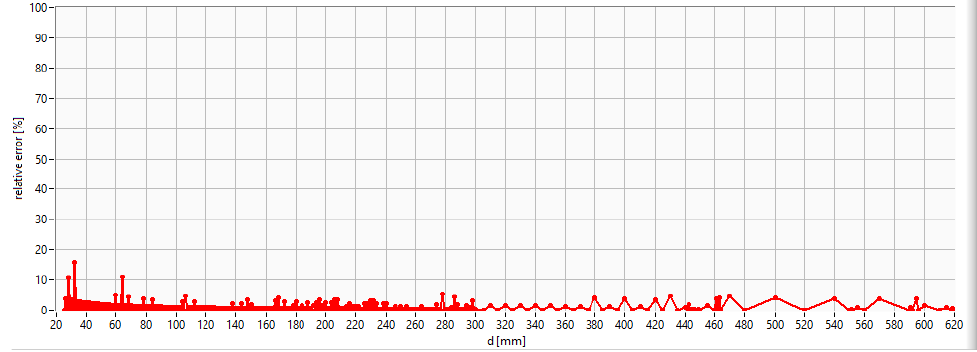
Figure 9. The graphical variation of relative errors on distance.